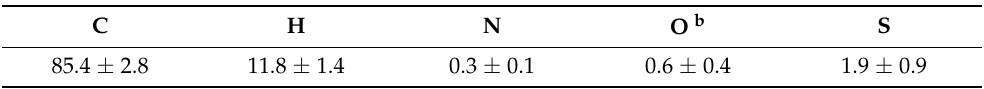
Table 3. Elemental composition (%) of the oil sample taken from the first step of oil purification after extraction, including dehydration and degasification a .